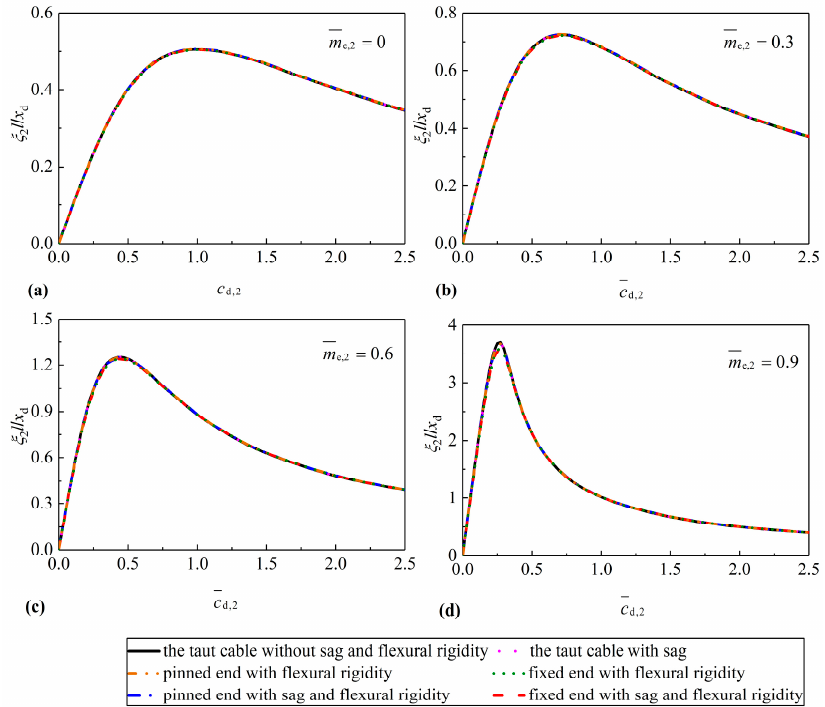
Figure 5. The second supplemental modal damping ratio of the short cable versus damping coefficient for various inertial masses: ( a ) m e,2 = 0; ( b ) m e,2 = 0.3; ( c ) m e,2 = 0.6; ( d ) m e,2 =